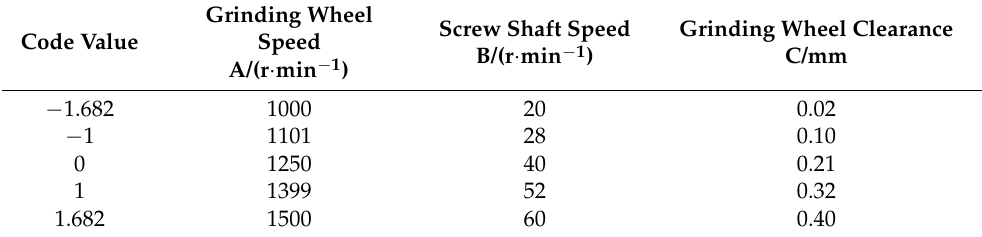
Table 2. Table of factors and level